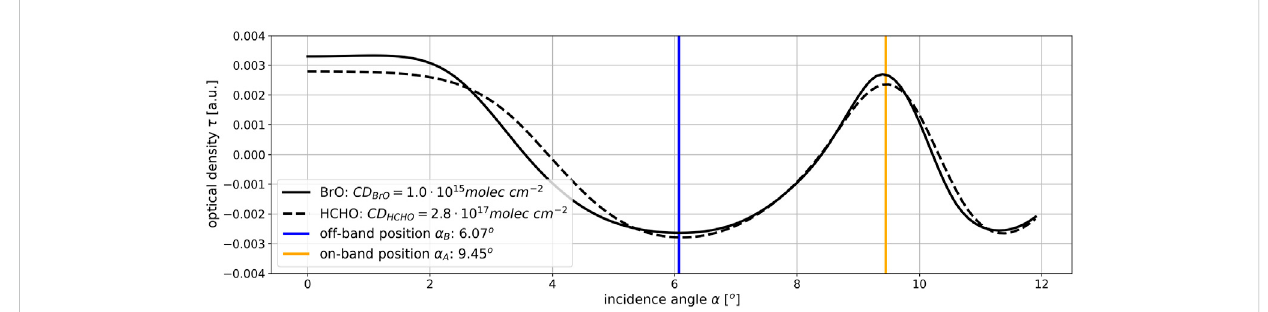
FIGURE 2 Modelled interferograms for BrO (CD BrO = 1.0 × 10 15 molec cm − 2 ) and HCHO (CD HCHO = 2.8 × 10 17 molec cm − 2 ). The BrO CD is chosen as atypical valueforvolcanicplumesandtheHCHOCDisscaledaccordingtohave asimilar absorption signal.Thevertical linesshowtheon-band (orange line)and off-band (blue line)measurement anglesfor theBrOmeasurement.On-band andoff-band measurement angles for BrOandHCHO arealmost identical in the spectral region of the used bandpass fi lter.